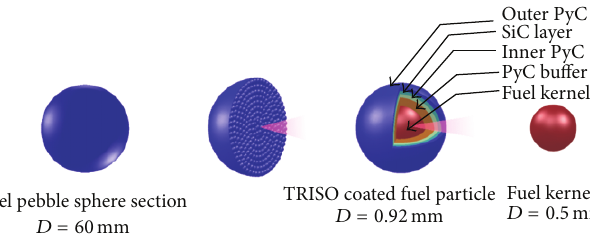
Figure 3: Fuel pebble sphere and TRISO coated fuel particle (PyC: pyrocarbon; SiC: silicon carbide).